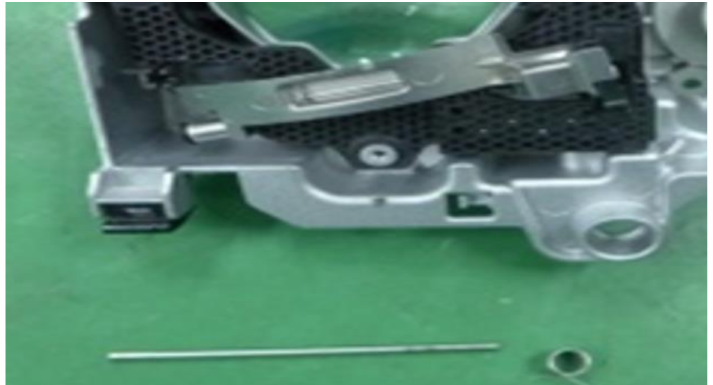
Figure 5. Breakdown of a return-spring in a bi-functional DC